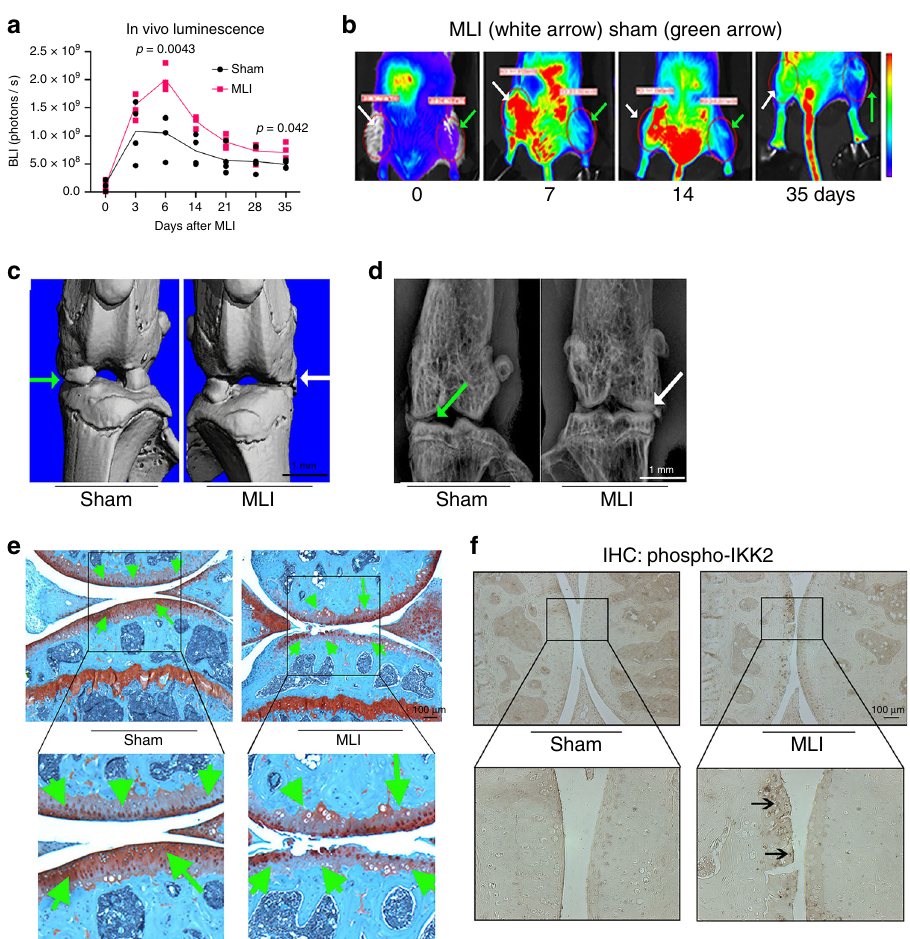
Fig. 2 NF- κ B is activated in chondrocytes of PTOA knee joints. MLI surgery was performed in 12-week-old NF- κ B-luciferase reporter mice. Right knee joints were operated for MLI surgery and left knee joints were used for sham surgeries ( n = 4 each group). a Bioluminescence imaging after MLI and sham surgery showed increased NF- κ B activation in the MLI surgery joint (right leg) compared to sham-operated knee joint in the same animals over 5 weeks. Graphs display mean ± S.D for n = 4 mice per side. Two-tailed student ’ s t -tests were performed at each timepoint comparing the two groups with p- values indicated in fi gure. b Representative images of bioluminescence imaging from the same mouse at various times after surgery. c Representative μ CT image and d X-ray image from one mouse showed joint damage, loss of synovial space and osteophyte formation in MLI surgery operated knee joint (white arrow). e Representative image of safranin-O staining of knee joints from same mouse shows loss of articular cartilage and proteoglycans after 8 weeks of MLI surgery compared to sham surgery. f Representative image from one mouse of IHC staining for p-IKK2 (arrows) in knee joints upon MLI surgery compared to sham surgery. e – f Scale bar = 100 μ